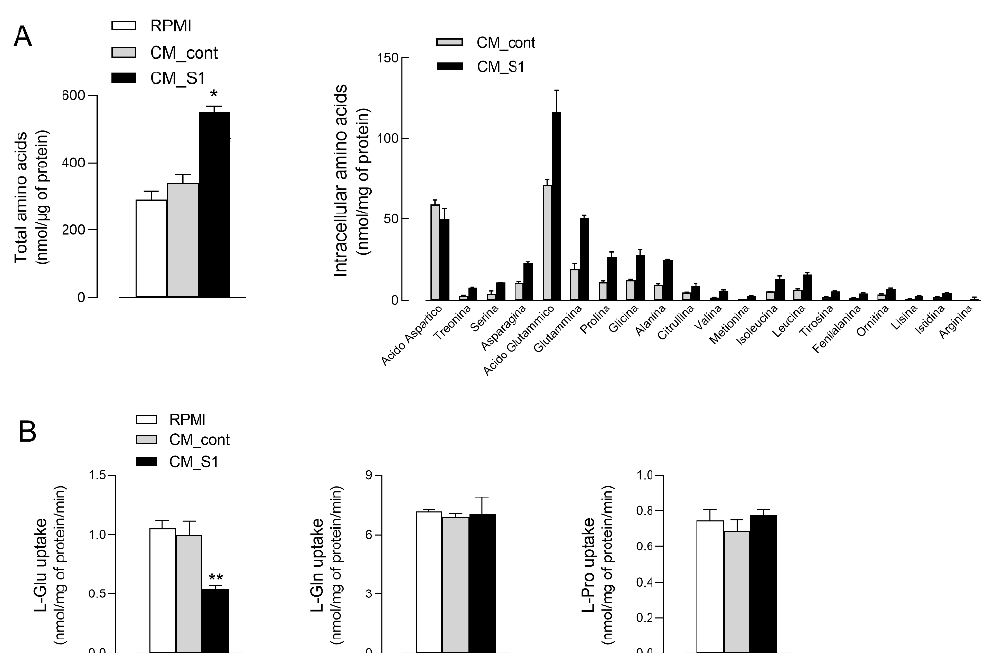
Figure 2. Effects of conditioned medium from S1-treated macrophages on the content and uptake of amino acids in alveolar epithelial cells. A549 cells were incubated for 24 h under the same conditions as in Figure 1. ( A ) Amino acid content. The intracellular pool of amino acids was analyzed as described in Methods. Total intracellular amino acid content (left) is calculated as the sum of the single indicated amino acids (right). Bars represent the mean ± SEM of three independent experiments. * p < 0.05 vs. CM_cont with ANOVA. ( B ) Amino acid transport. Uptake of 3 H-L-glutamic acid, 3 H-L-glutamine and 3 H-L-proline was determined as described in Methods. Bars represent the mean ± SD of four independent determinations within a representative experiment that, repeated three times, gave comparable results. ** p < 0.01 vs. CM_cont with ANOVA.